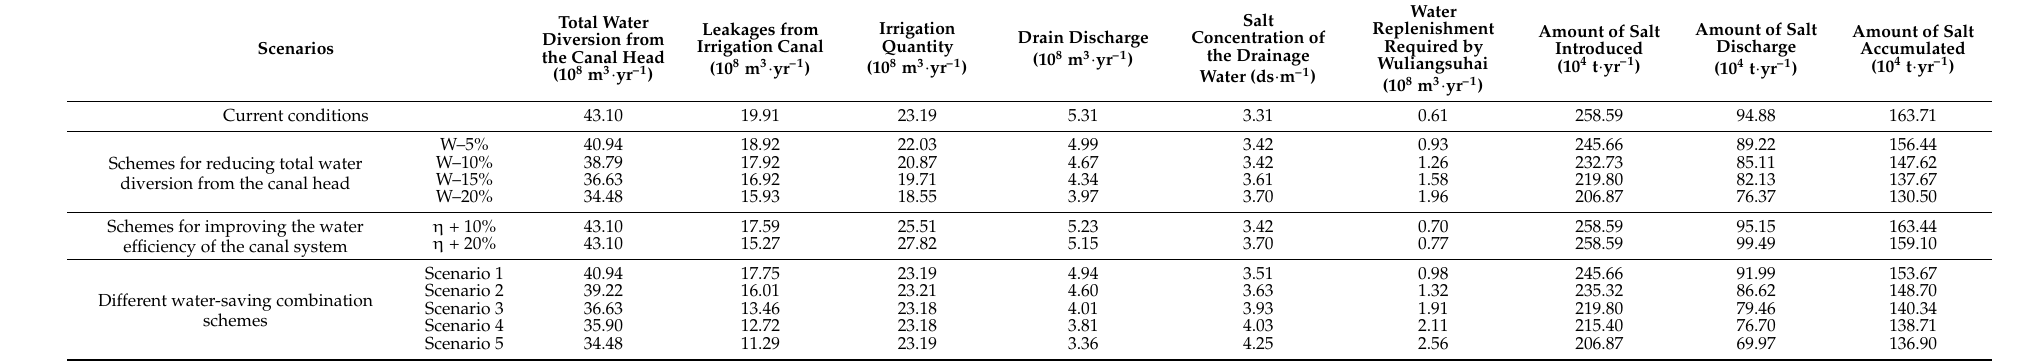
Table 7. Comparison of calculation results of different water-saving